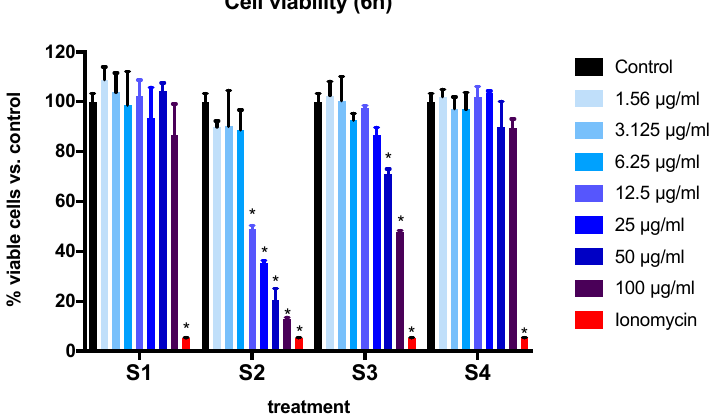
Figure 2. BEAS-2B cell viability expressed as percentage of viable cells at 6 h after exposure to four different soot preparations (S1–S4). The bars summarize data from three independent experiments ( n = 3 replicates per experiment) with results normalized to control (cells exposed to DMSO). Data are expressed as mean ± SEM. * p < 0.001 (Dunnett’s post hoc multiple comparisons test). Two-way ANOVA interaction: p < 0.0001, F (21, 40) = 7.640; concentration e ff ect: p < 0.0001, F (7, 40) = 25.67);